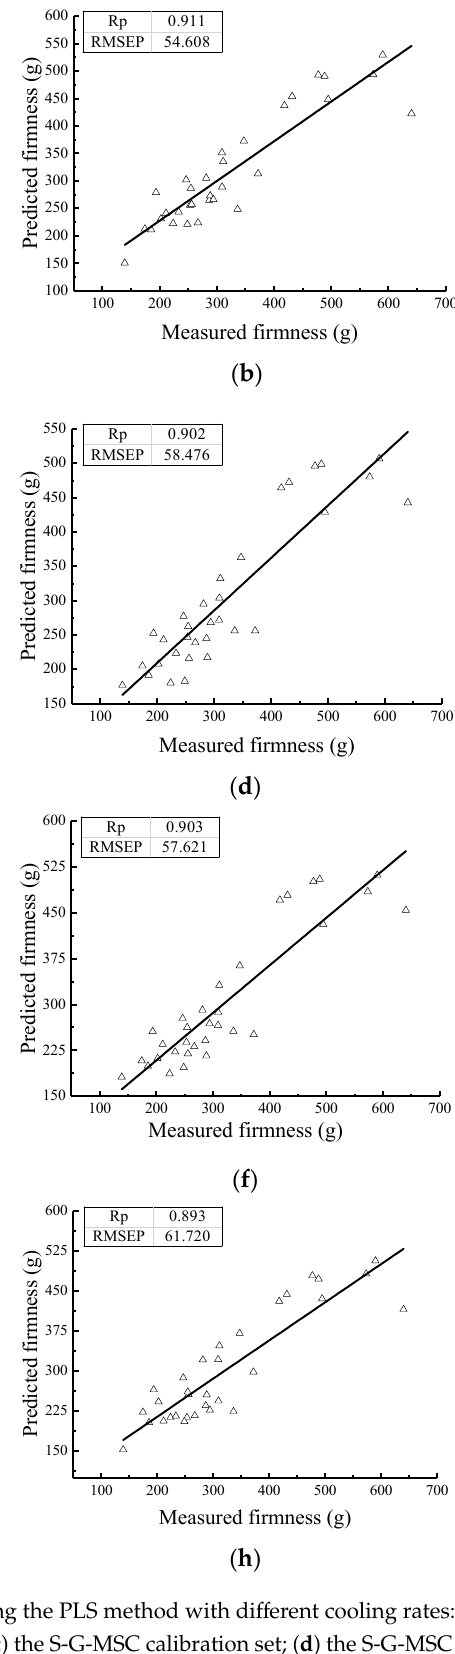
Sample numbers Figure 8. Scatter plot of the distribution of the firmness values of the Nanguo pears. From Figure 8, it can also be concluded that the firmness value of the fresh group is the largest, followed by the firmness value of the Nanguo pears subjected to a 5°C/min cooling rate, with an average value of 309.00 g. The firmness of the Nanguo pears subjected to a cooling rate of 3°C/min is slightly higher than that of the Nanguo pears subjected to a 1°C/min cooling rate. The average values are 234.09 g and 225.25 g, respectively, and the standard deviations are approximately 60 g and 53 g, respectively. The faster the cooling rate, the better the firmness of Nanguo pear is maintained. The PLS method was used to establish the firmness value model of the Nanguo pears. The results of the PLS models for the Nanguo pear firmness values from the calibration set and the validation set are shown in Figure 9. The pears were treated with different cooling rates (fresh, 1°C/min, 3°C/min, and 5°C/min). Figure 9 shows that the correlation coefficients of the calibration set and the validation set of the model with the different pretreatments are both greater than 0.85, which illustrates that the models both can predict unknown variables. The performance of the model with MSC pretreatment